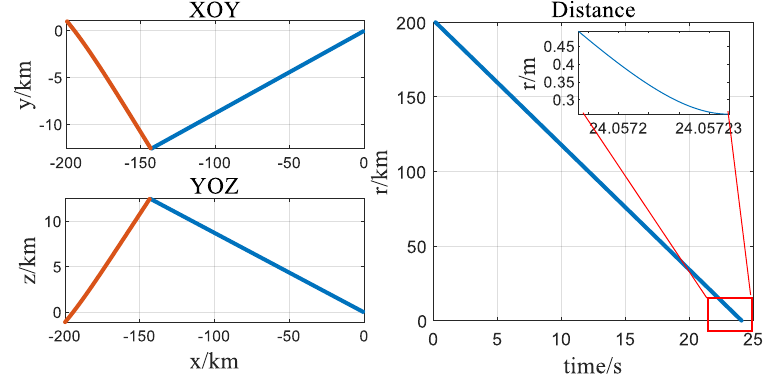
Figure 9. Evader employing a square maneuver.